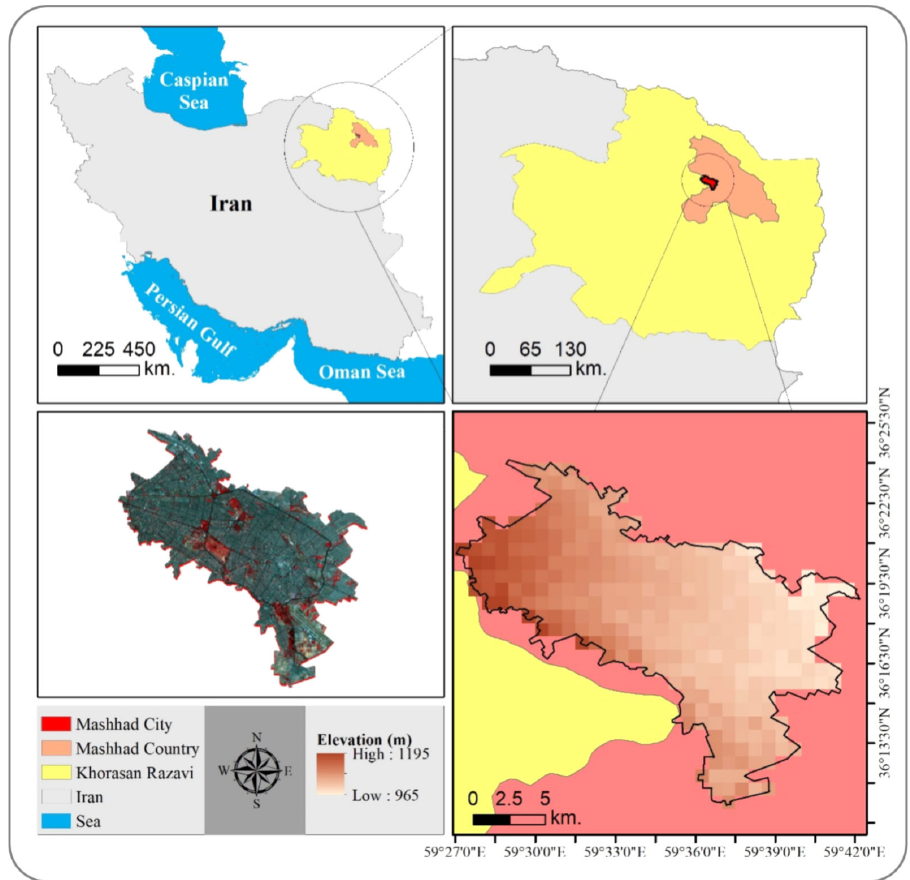
Figure 1. Presentation of study area; location of Khorasan Razavi province in Iran ( top left ), location of Mashhad country ( top right ), location of Mashhad city, together with its elevation image ( bottom right ), and false-color composite image of Mashhad City ( bottom left ) from Landsat 8 bands (3, 4, and 5) on 14 September 2019 (www.earthexplorer.usgs.gov, accessed on 30 July 2020). Table 1. The information about the Landsat datasets used to obtain Mashhad LU/LC and LST maps. Sensor Scene